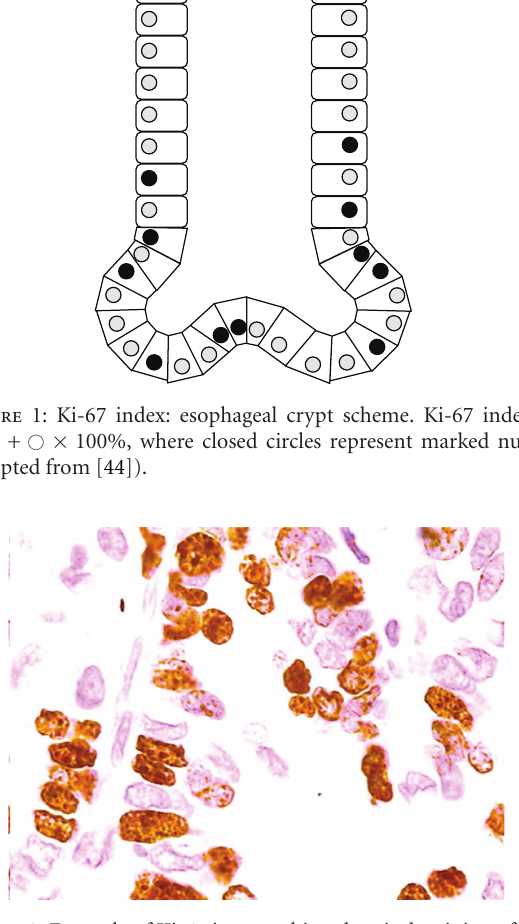
Figure 2: Example of Ki-67 immunohistochemical staining of eso- phageal tissue in a patient with esophageal adenocarcinoma, in 400x field (stained cells are marked with an arrow).